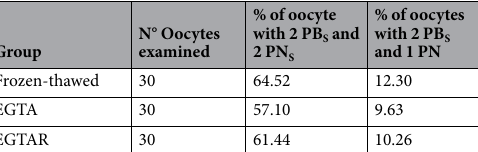
Table 1. Female and male pronucleus formation in in vitro matured oocytes after injection with frozen-thawed and freeze-dried sperm. PB: polar body; PN, pronucleus .